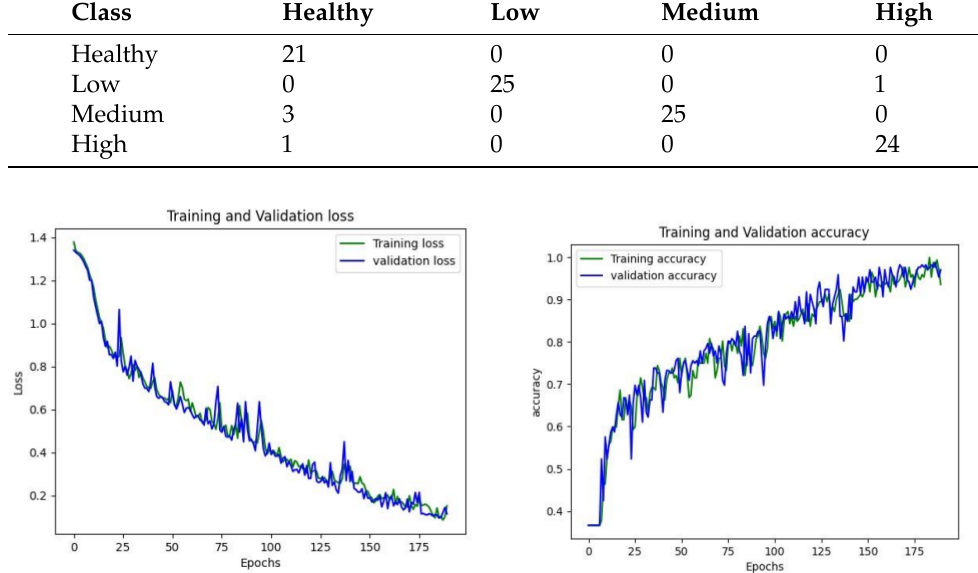
Figure 8. Loss and accuracy curves of the implemented model.